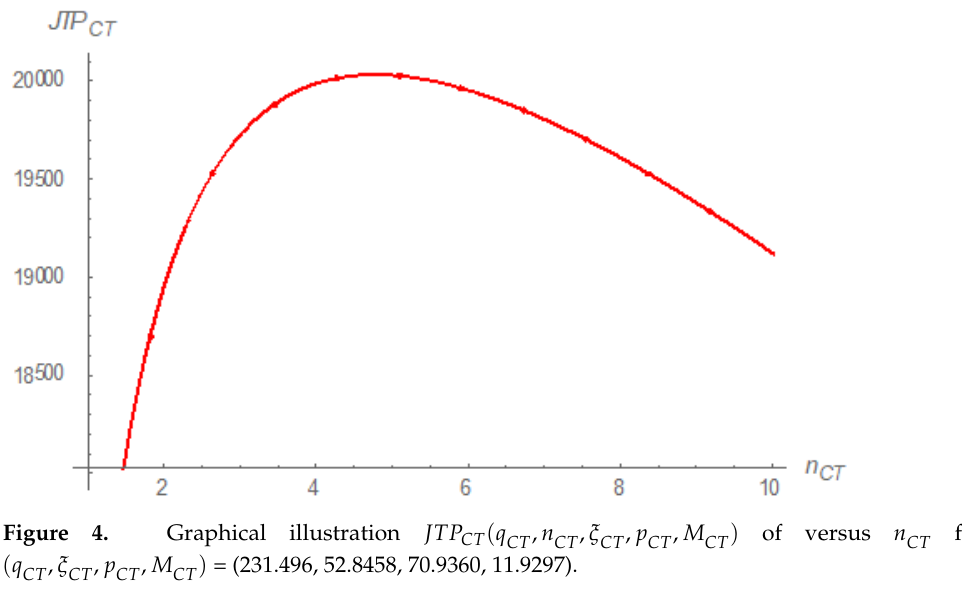
Figure 3. Graphical illustration JTP CC ( q , ξ , p , M CC CC CC CC ) = (345.972, 89.3402, 72.6989, 9.9365).